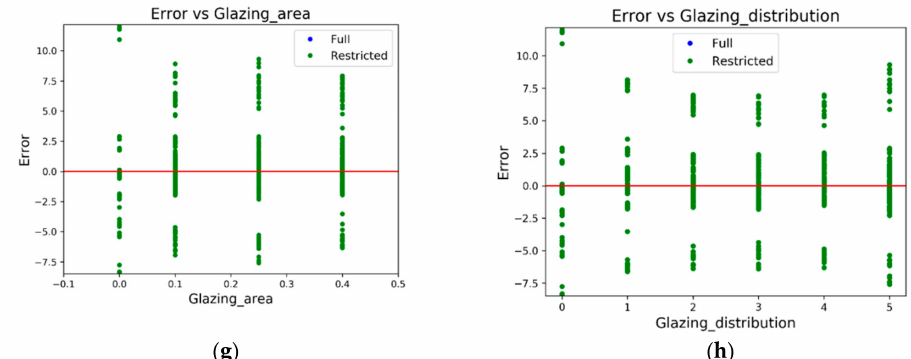
Figure 6. Errors over independent variables. ( a ) Relative compactness; ( b ) Surface area; ( c ) Wall area;